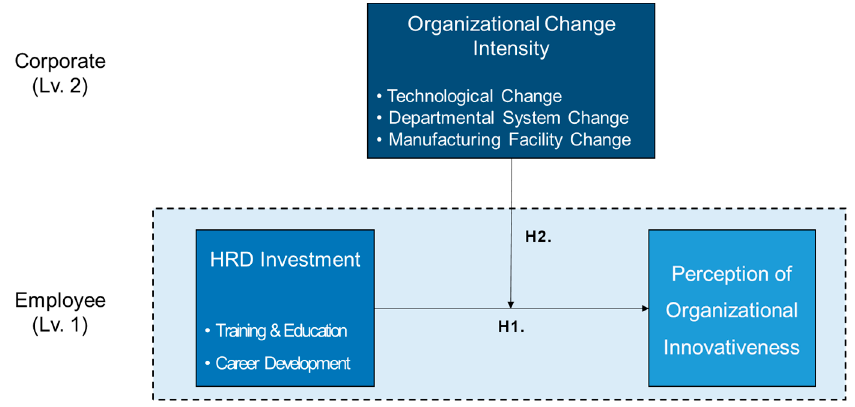
Figure 1. Research model. Human resource development (HRD).